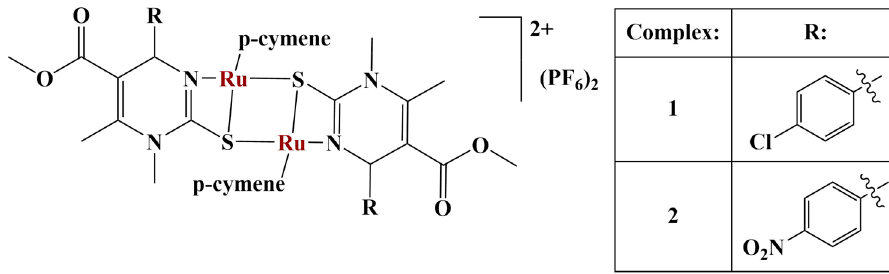
Figure 15. The complexes presented in [61].